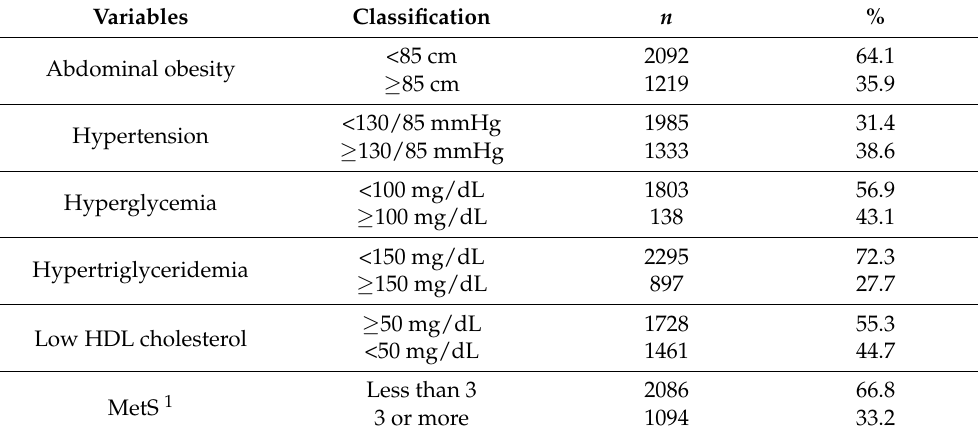
Table 1. Distribution of MetS and its